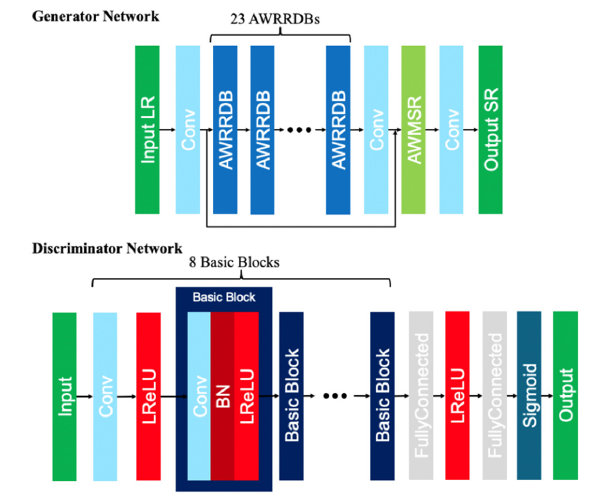
Figure 4. Simplified network architecture of the MARSGAN model [43].